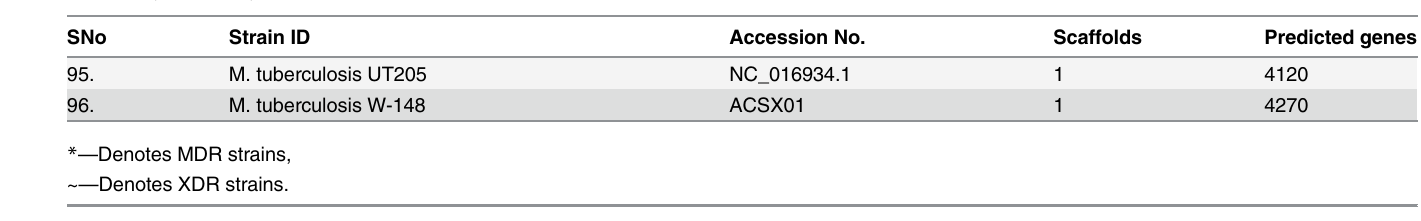
are available at http://genome.igib.res.in/Mtb_Pangenome.